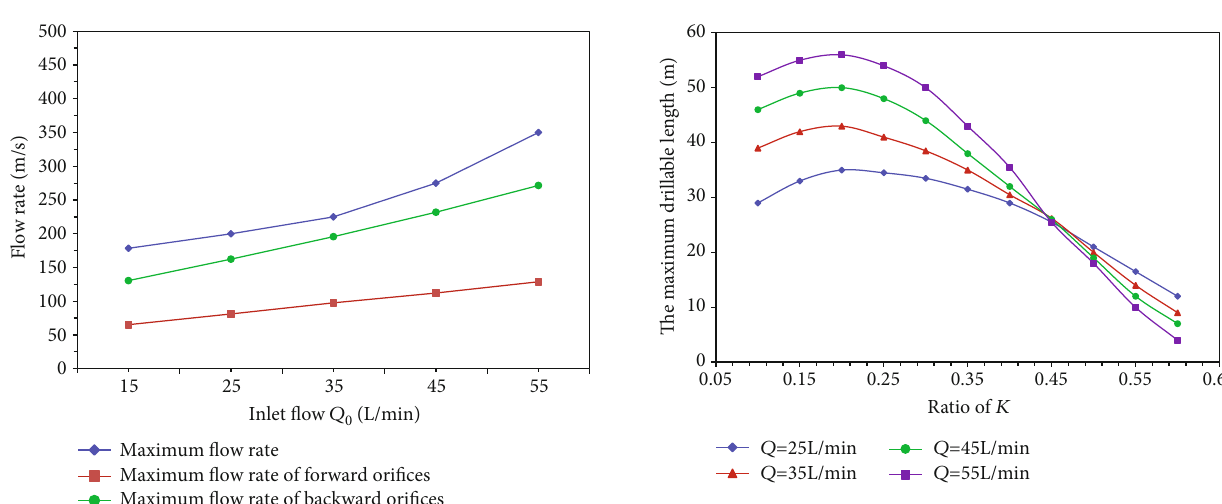
Figure 8: E ff ect of the ratio K on the maximum drillable length for representative values of Q .